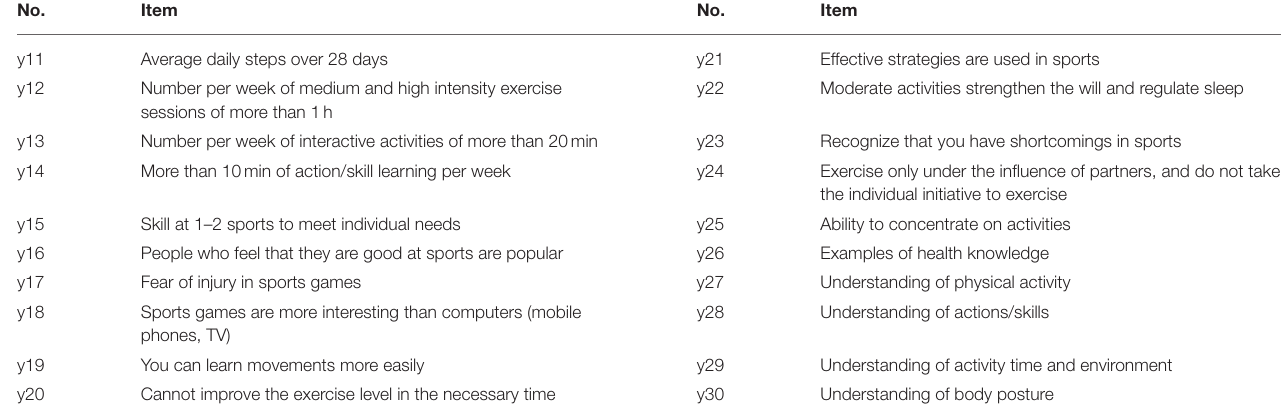
TABLE 2 | Motor behavior